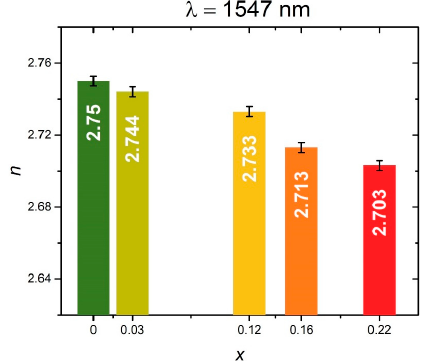
Figure 1. Dispersion of the terahertz refractive index for an ordinary wave of GaSe:S crystal samples. The x value is labeled for each curve. Symbols—experimental data, solid curves—approximation by Equation (1).